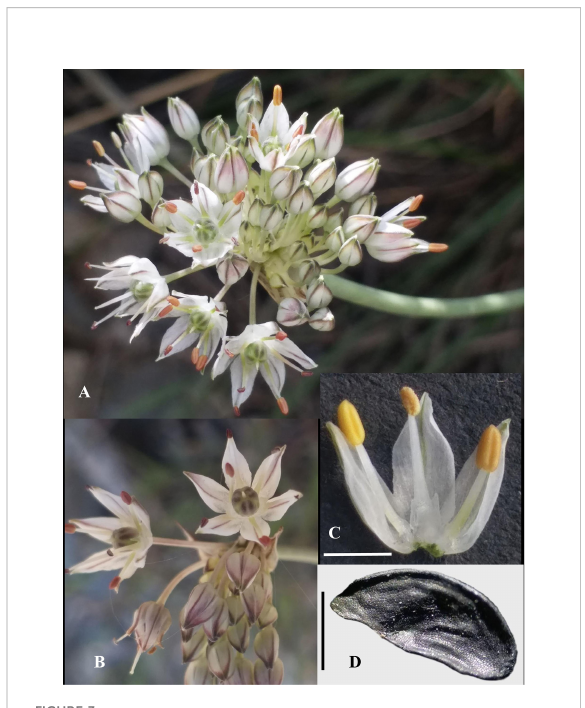
FIGURE 3 Allium sulaimanicum . (A, B) In fl orescence (C) Flower section with tepals and stamens (scale bar: c 1.5 mm) (D) seed (scale bar: c 1 mm) (Photos by Nazar